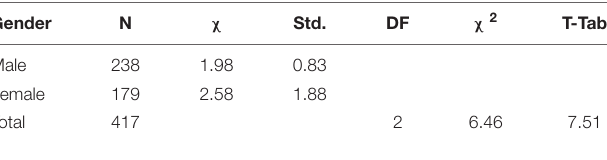
TABLE 3 | Chi-square statistic for teaching strategies and Students’ self-identity and self-esteem.